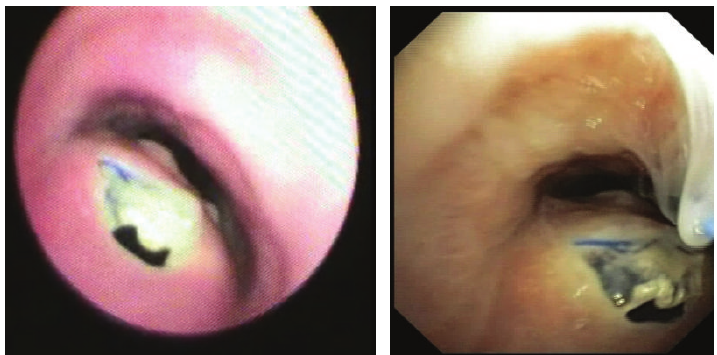
Figure 1: Flexible bronchoscopic image showing prolapse and erosion of the proximal end of esophageal stent through the posterior tracheal wall and formation of tracheoesophageal fistula (TEF).